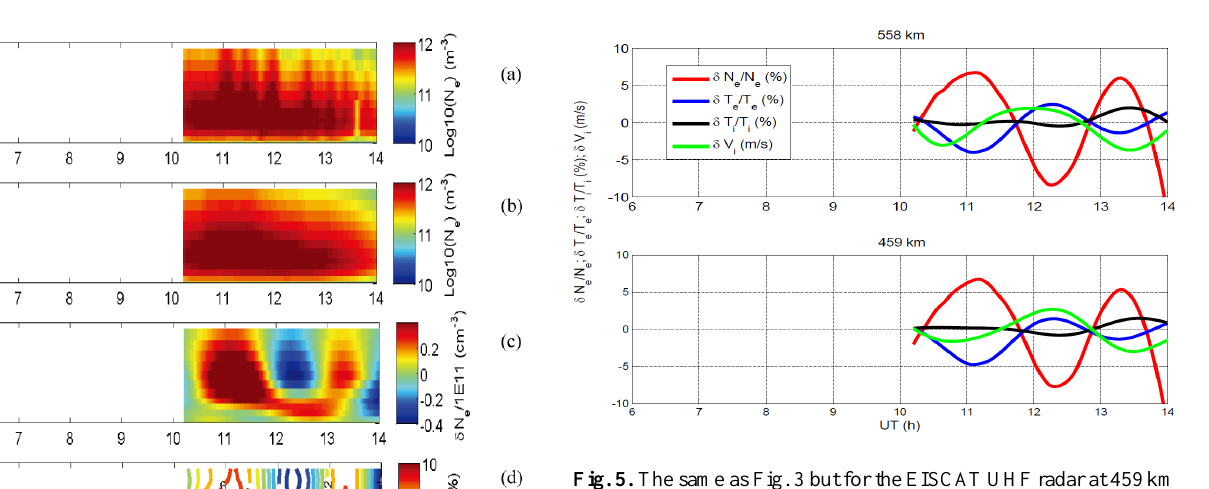
Fig. 5. The same as Fig. 3 but for the EISCAT UHF radar at 459km Figure 5. The same as Figure 3 but for the EISCAT UHF radar at 459 km (bottom (bottom panel) and 558km (top panel). The white space in the in- panel) and 558 km (top panel). The white space in the interval from 0600 to 1000 UT terval from 06:00 to 10:00UT is due to a data gap. is due to a data gap.